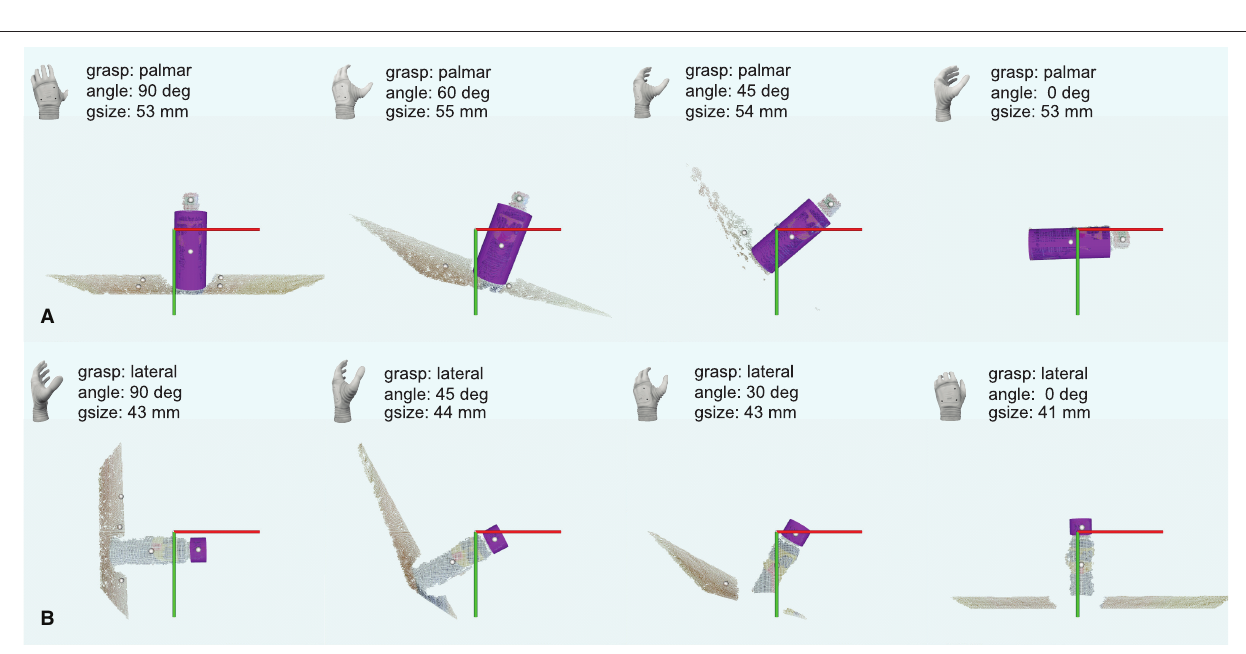
FIGURE 7 | A sequence of snapshots taken while the system approached two different cylindrical parts of the same object: the body (A) and the cap (B) of a spray can. The annotations are the same as in Figure 5 . Note that the can body was approached with a fully pronated prosthetic hand, while the cap was approached with the hand in the neutral